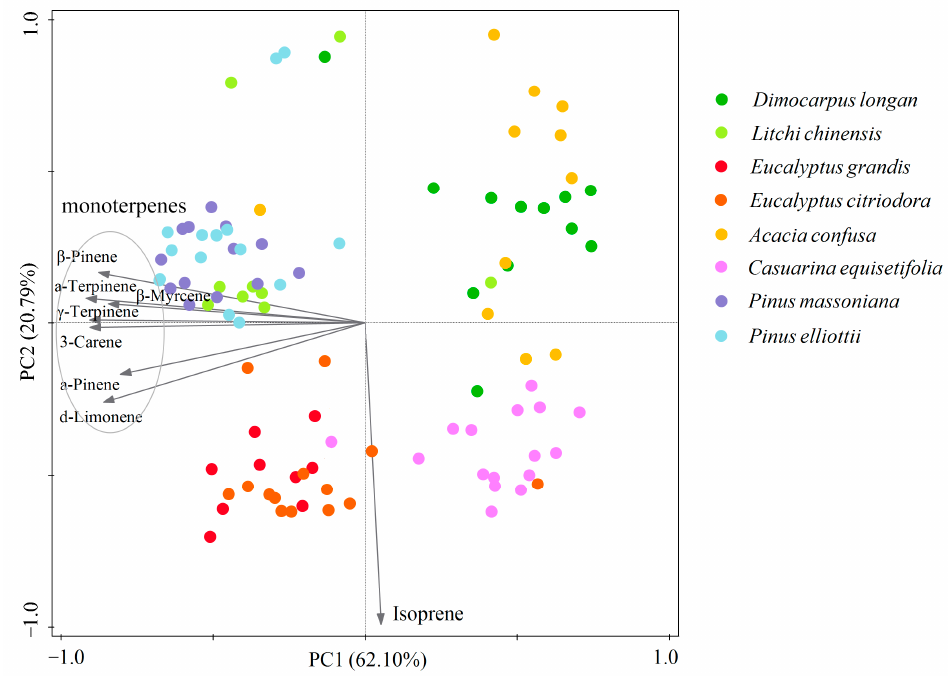
Figure 4. Principal component analysis of the emission rates of isoprene and monoterpenes ( α -pinene, β -myrcene, β -pinene, 3-carene, α -terpinene, d-limonene and γ -terpinene) of the eight woody trees.